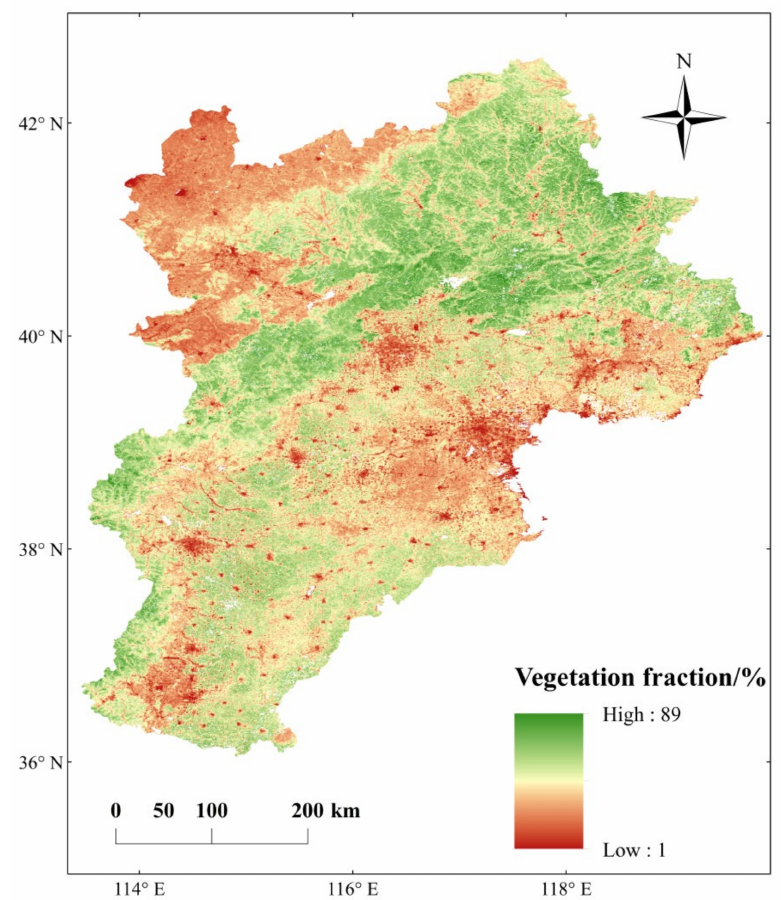
Figure 8. Average spatial distribution of fractional vegetation cover in the Beijing-Tianjin-Hebei region in 2018 and